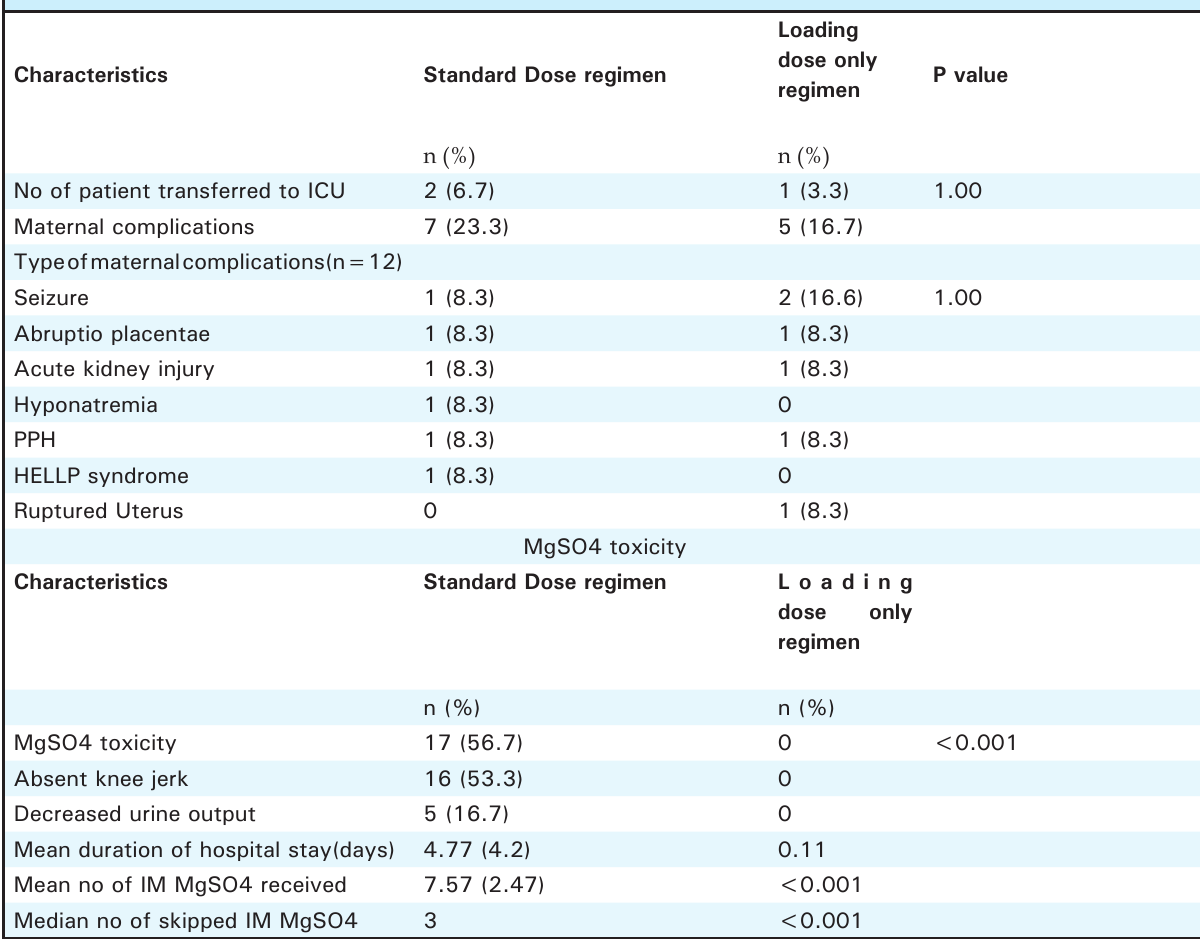
Table 2. Maternal